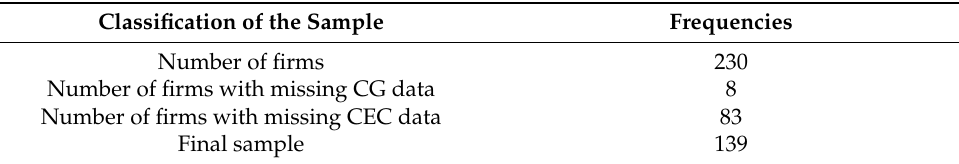
Table 1. Sample description: Italian firms,